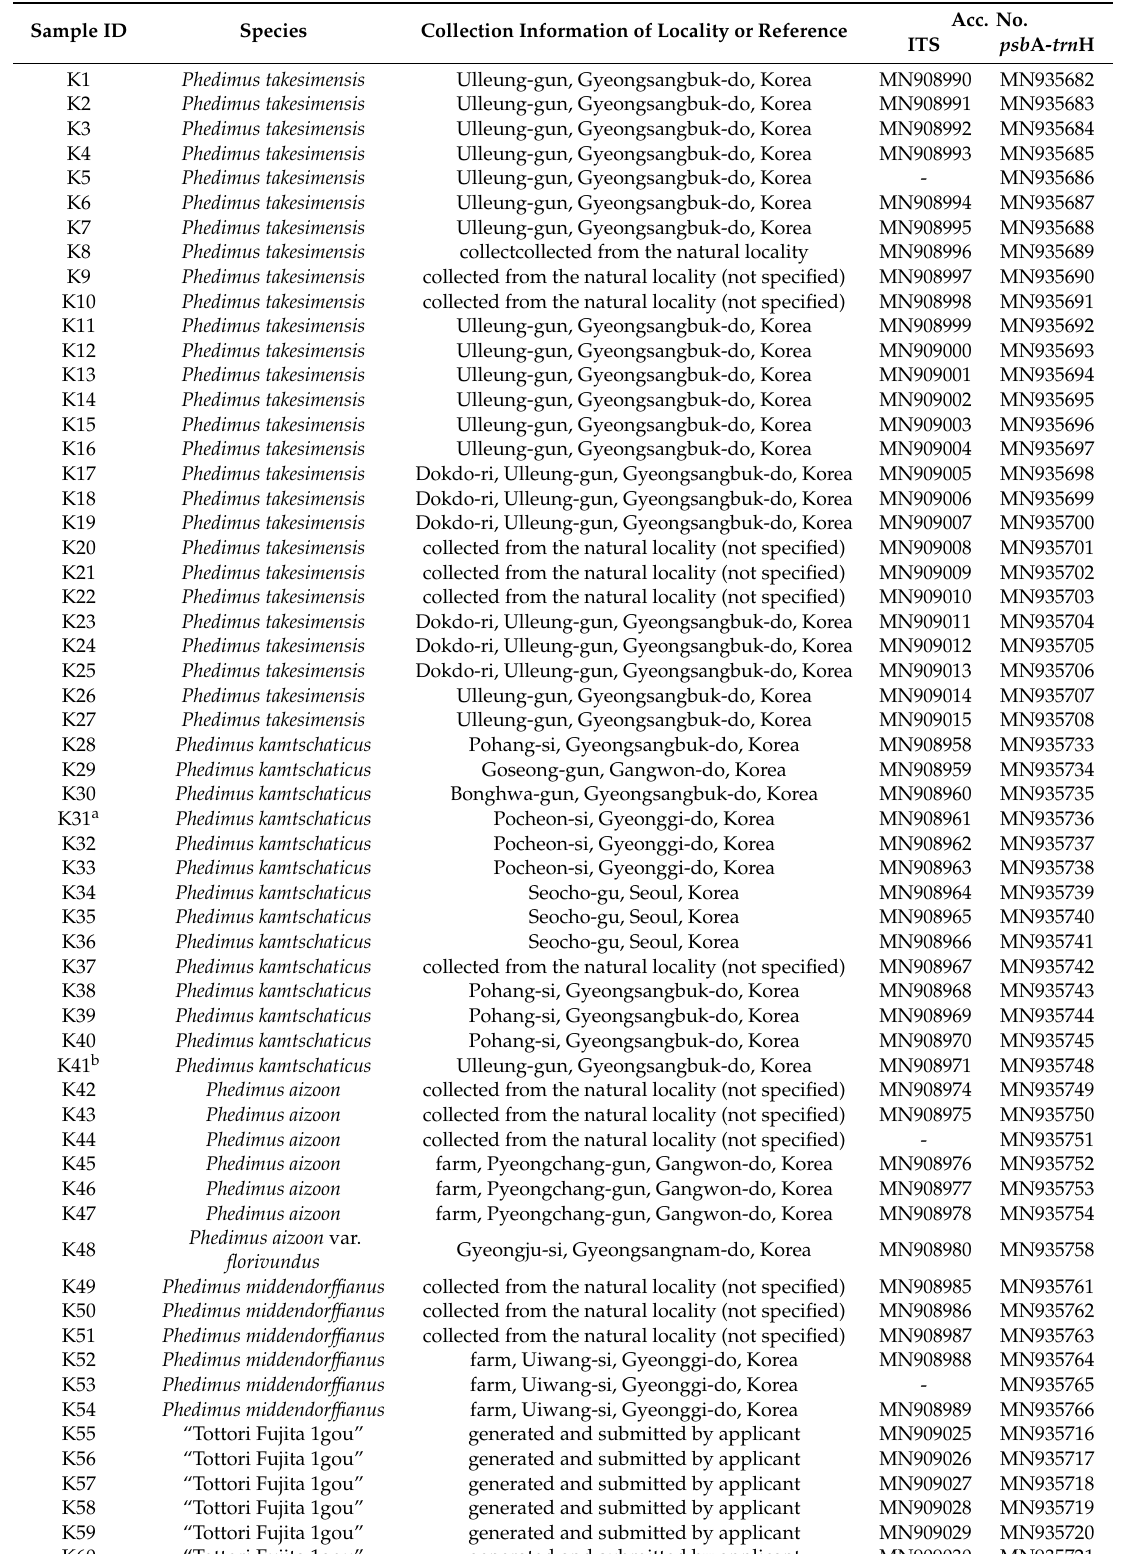
Table 1. List of plant materials with accession numbers deposited in the National Center for Biotechnology Information (NCBI)